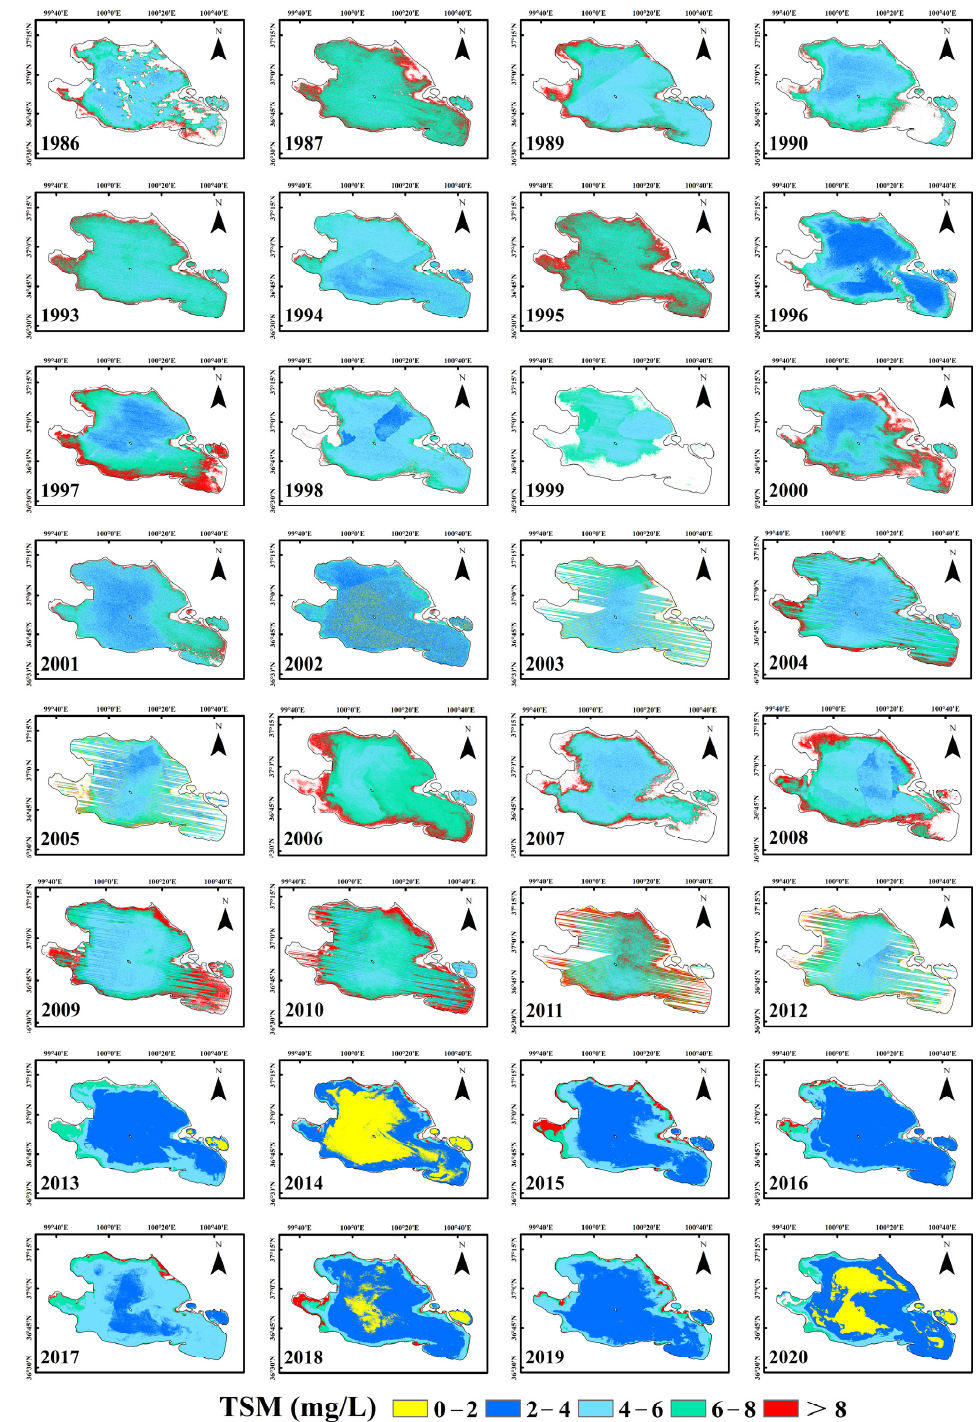
Figure A1. The spatial distribution of TSM of Lake Qinghai from 1986 and 2020 using Landsat sensors, including ETM+, TM, and OLI. We used the year average values of all images available within a given year.